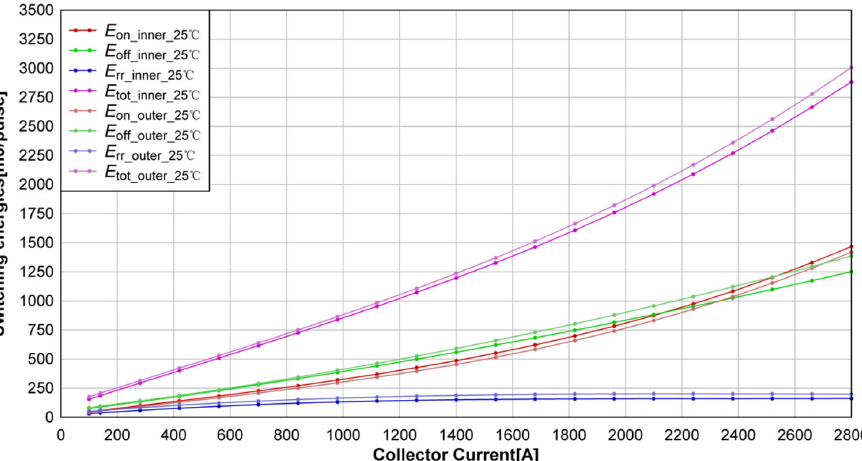
Figure 27. IGBT switching energies between the inner and the outer commutation paths at 25 °C.